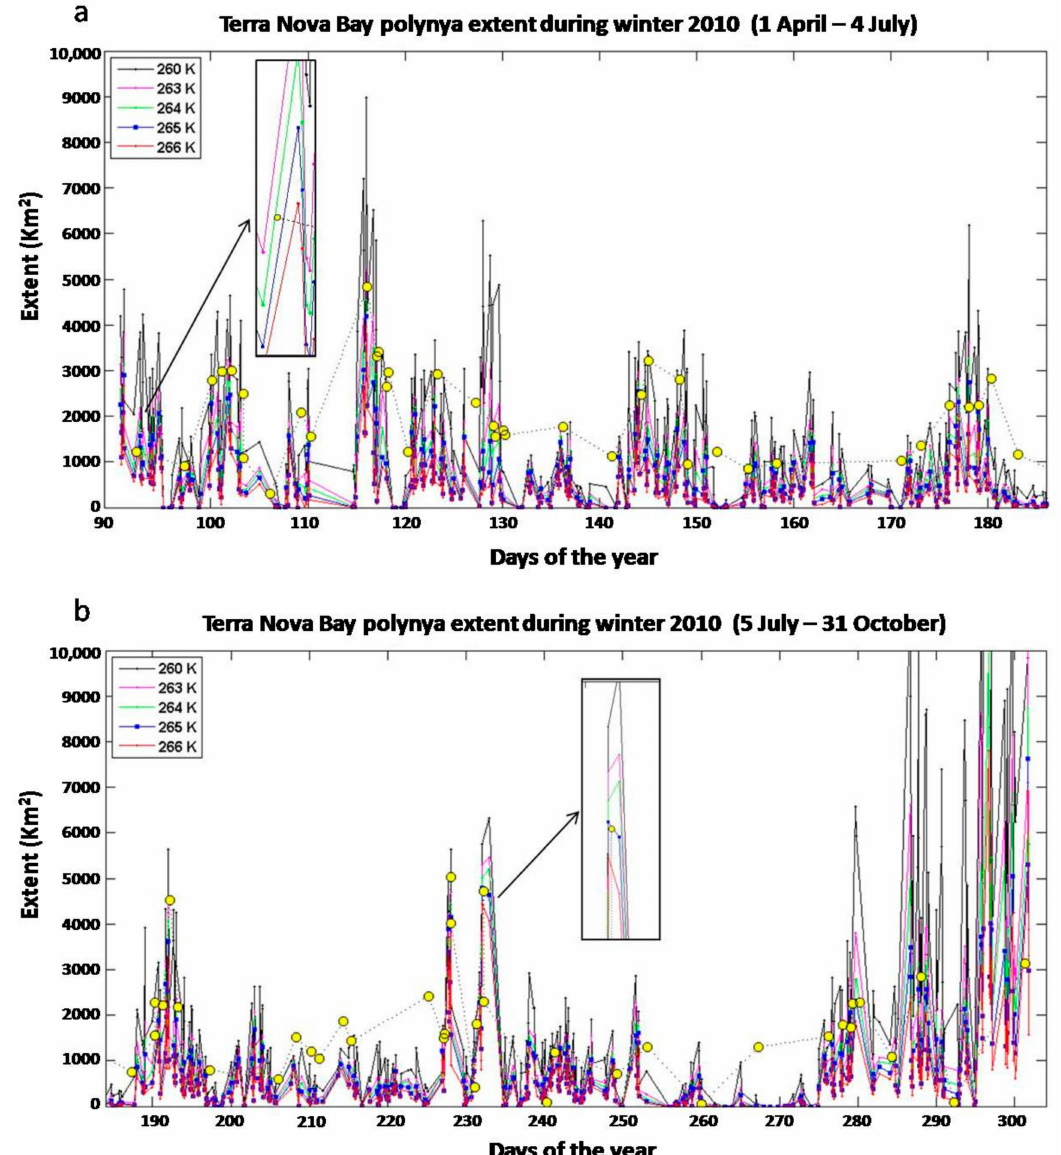
Figure 10. Thermal threshold sensitivity test for winter season 2010. The study period is divided in two intervals: ( a ) 1 April–4 July; ( b ) 5 July–31 October. TNBP extent retrievals are represented through different colors when using different thresholds, as described in the legend. Yellow circles report the ASAR Envisat co-located retrievals. Black rectangles present a zoom on days ( a ) 92–93 (2–3 April); and ( b ) days 232–233 (20–21 August), the case study fully analyzed in Figure